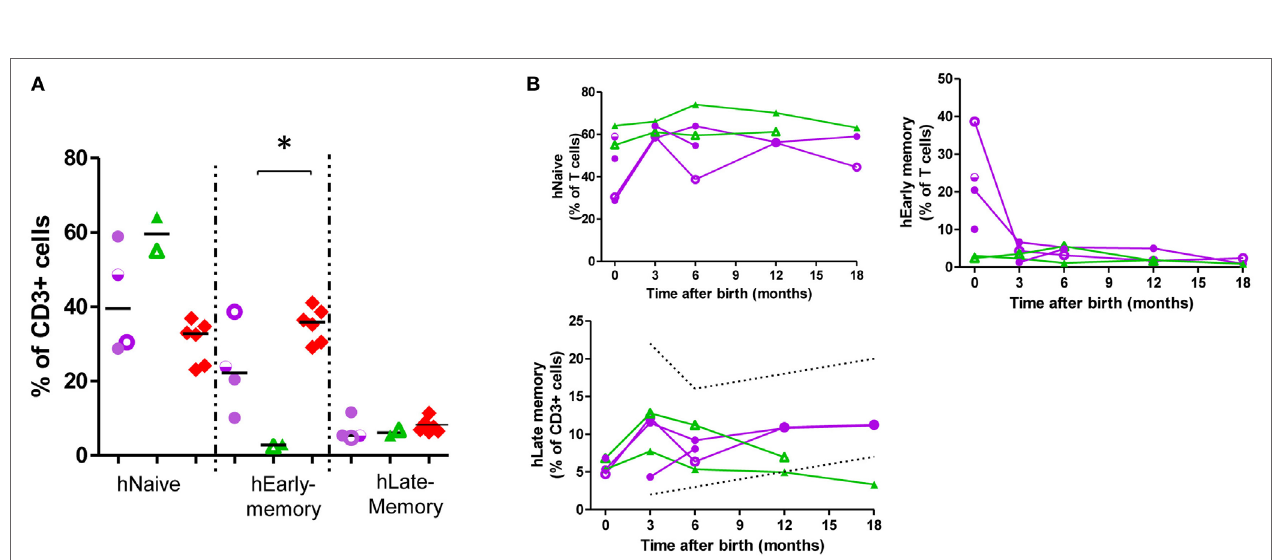
FigUre 1 | Anti-TNF- α drug levels. (a) Anti-TNF- α levels in cord blood. (B) Correlation between mother’s adalimumab (ADA) trough level during the third trimester of pregnancy and level in cord blood. (c) Clearance of the anti-TNF- α monoclonal antibodies. Purple circles: ADA-exposed; green triangles: infliximab (IFX)-exposed, empty symbols: co-exposure with azathioprine; half-empty symbols: co-exposure with prednisone. ADA-exposed infants, n = 5; IFX-exposed infants, n =